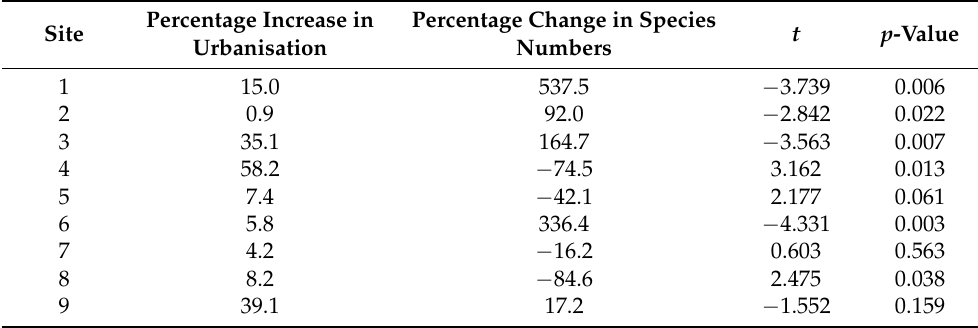
Table 1. Results of paired t -test for difference in the overall number of bird species per site between 1998 and 2018 in areas where urbanisation has increased (df = 8).